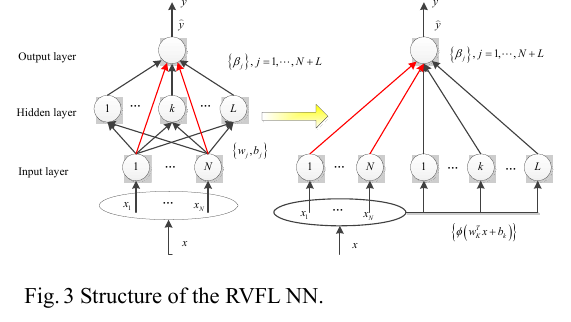
Fig. 3 Structure of the RVFL NN.